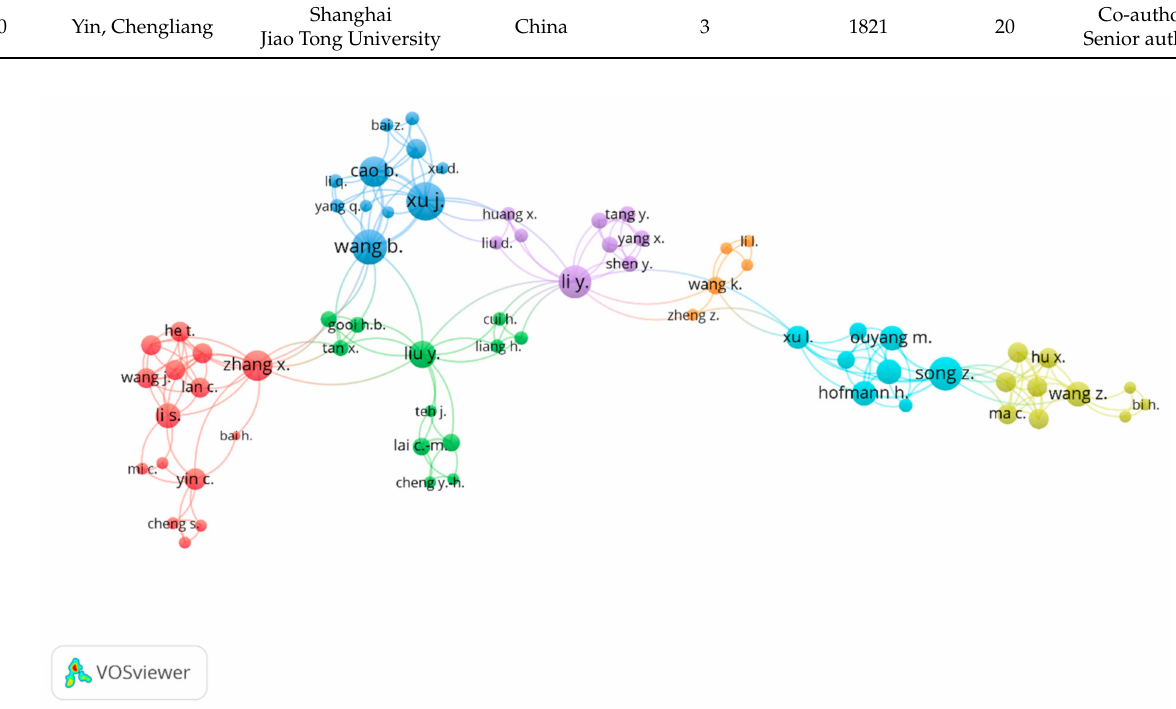
Figure 11. VOSviewer illustration for co-authorship analysis using Scopus